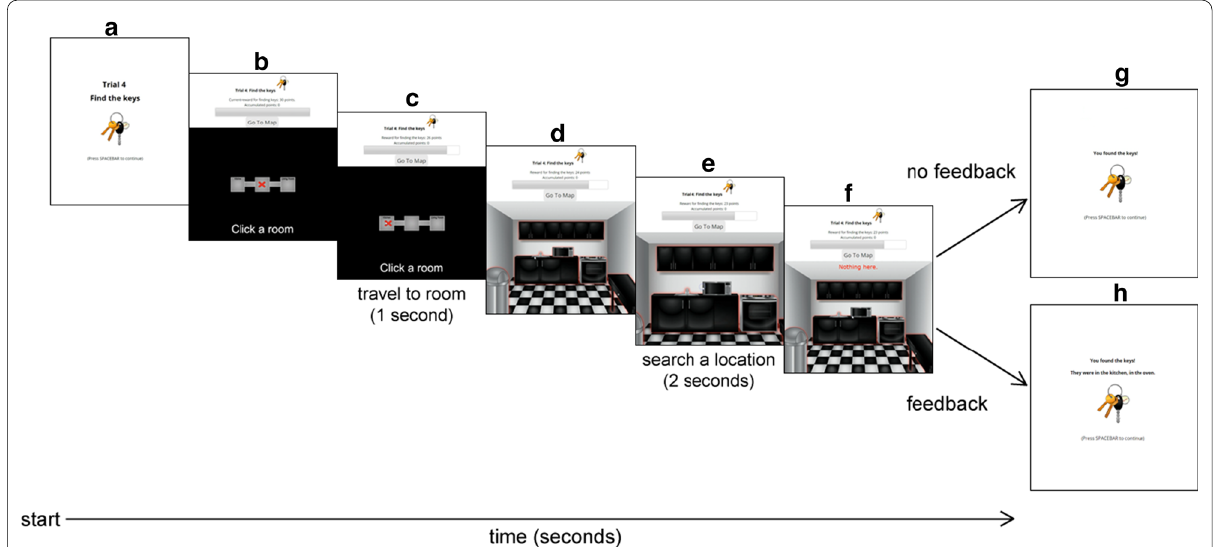
Fig. 5 Schematic of the trial